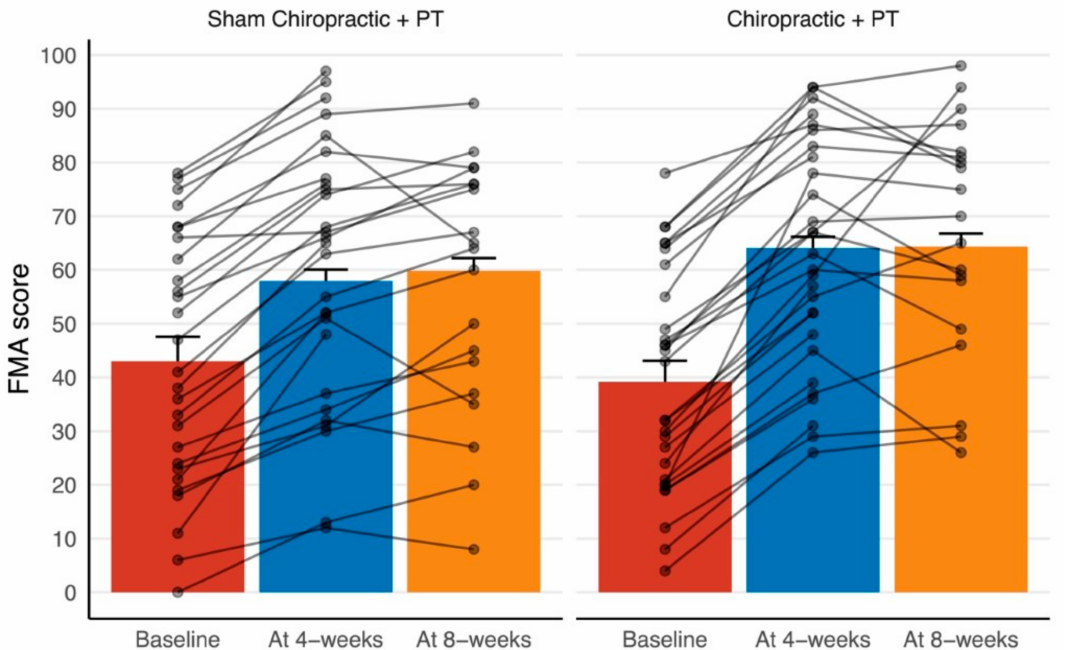
Figure 2. Participant-wise FMA scores, along with group-wise means and standard errors for the two interventions at pre-randomization baseline, at the end of the interventions (4 weeks), and the follow-up (8 weeks). Note: FMA stands for Fugl-Meyer Assessment and PT stands for physical therapy. The baseline means and standard errors are calculated from the raw data, whereas the remaining statistics are from the fitted model, which computes means and standard errors after adjusting for the baseline scores. Similar illustrations of remaining outcomes are available in the supplementary